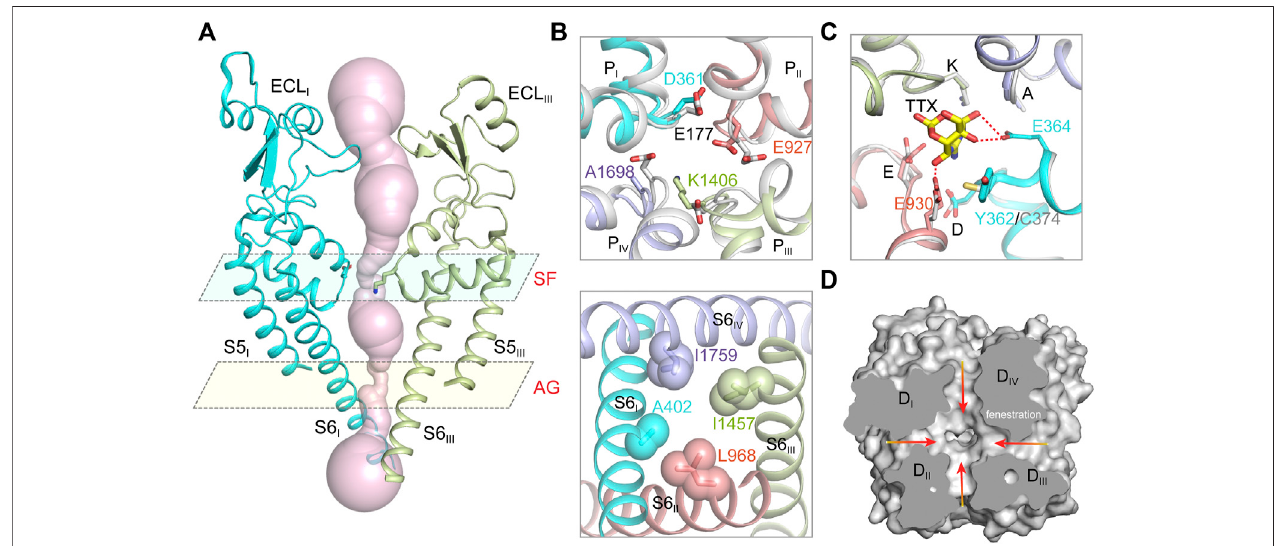
FIGURE 2 | The ion path of mammalian Na V channels. (A) The pore radii of human Na V 1.7 (PDB code: 7XM9) calculated by HOLE. Only two opposing subunits shown for clarity. The constriction sites of selectivity fi lter (SF) and intracellular activation gate (AG) are highlighted. (B) A close-up view of the SF (top panel) and AG (bottom panel) ofhuman Na V 1.7 (PDB code: 7XM9). TheSF of Na V 1.7 was aligned with the SF ofNa V Ab (gray, PDB code:3RVY).The side-chains ofkeyresidues in the SFandtheAGaredepictedinsticks. (C)